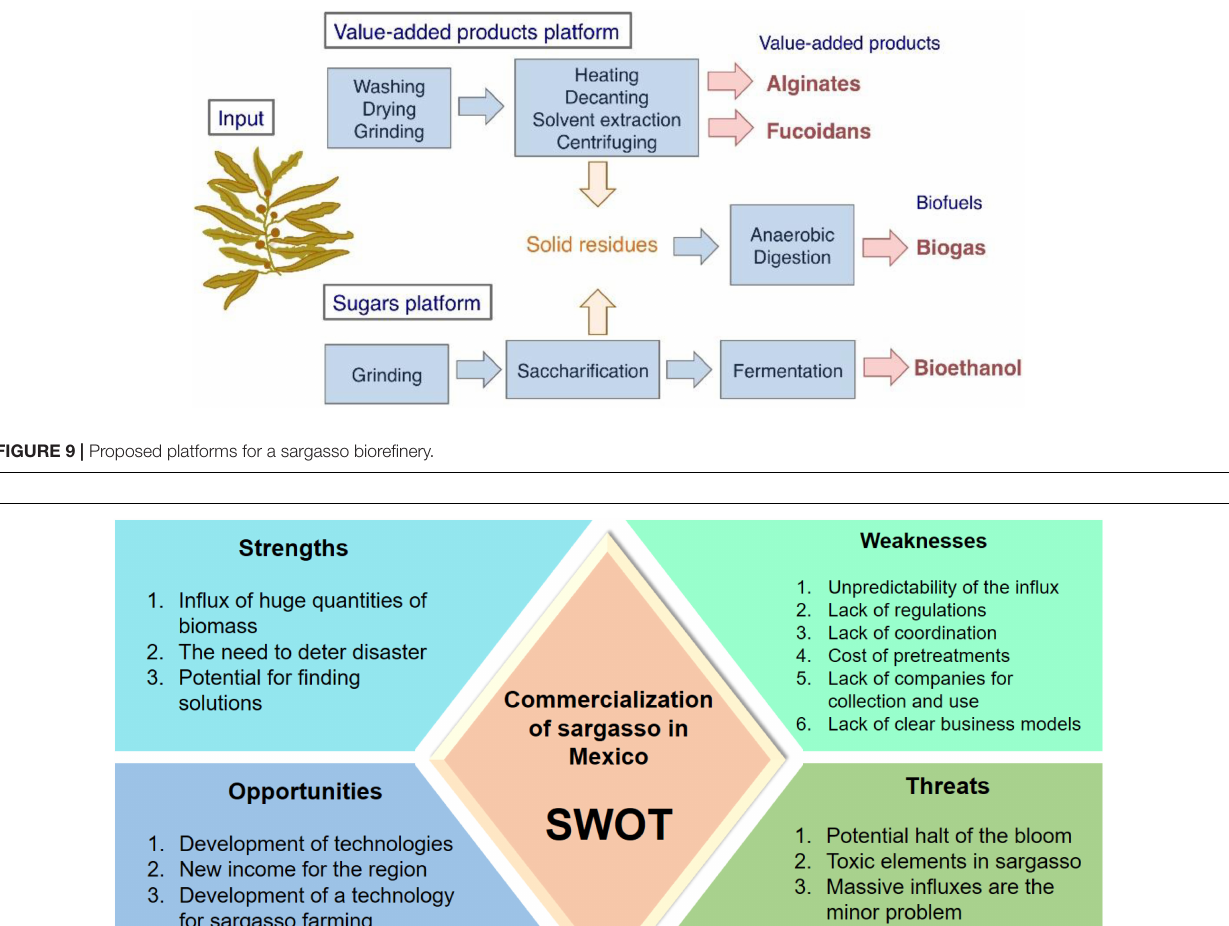
of the skin, making it attractive in the manufacture of anti-aging products (Jesumani et al.,